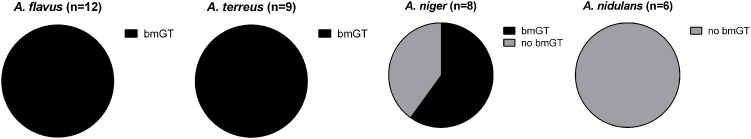
Percentage of GT-methylating isolates of Aspergillus species.